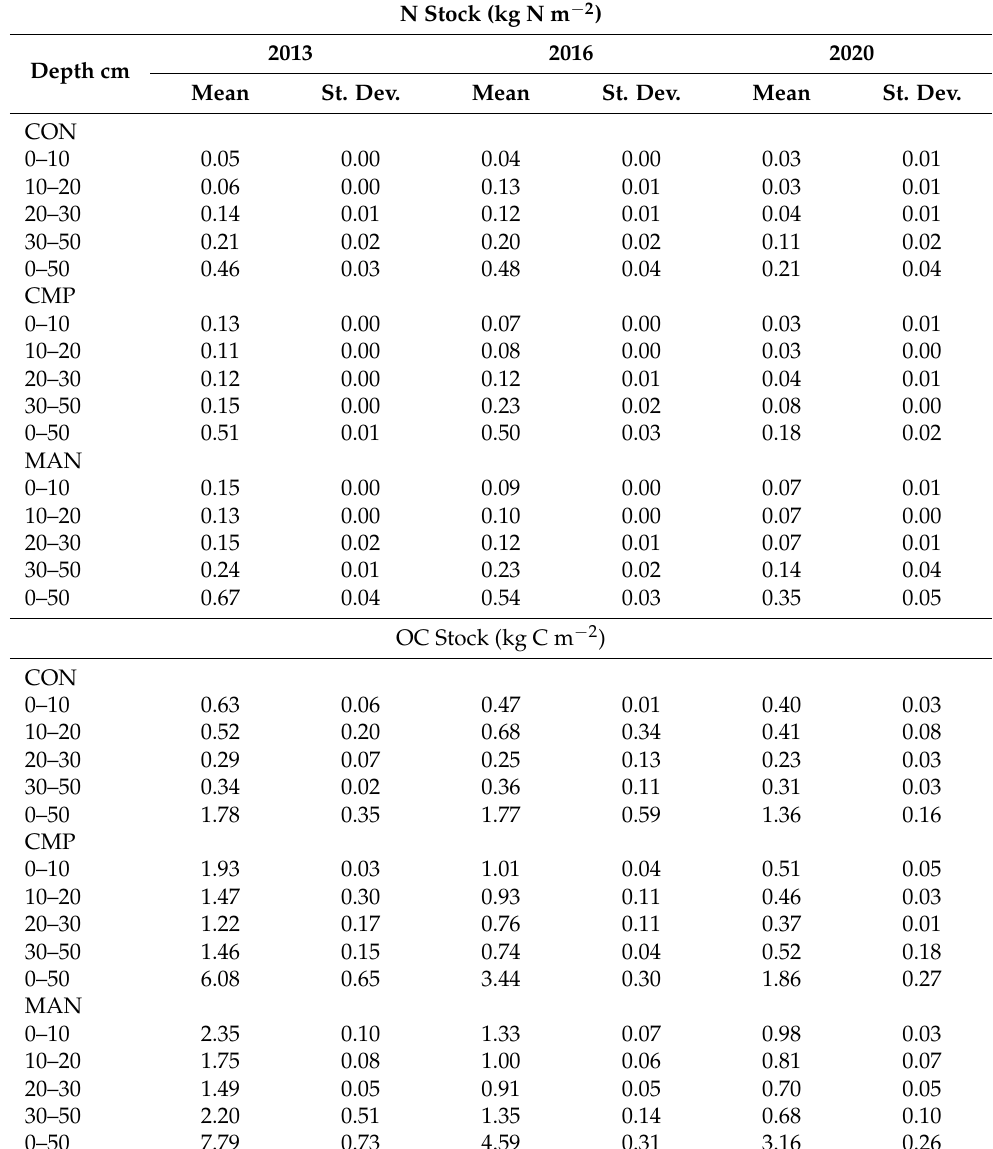
Table 3. Soil OC stocks and soil N stocks for 2013, 2016, and 2020